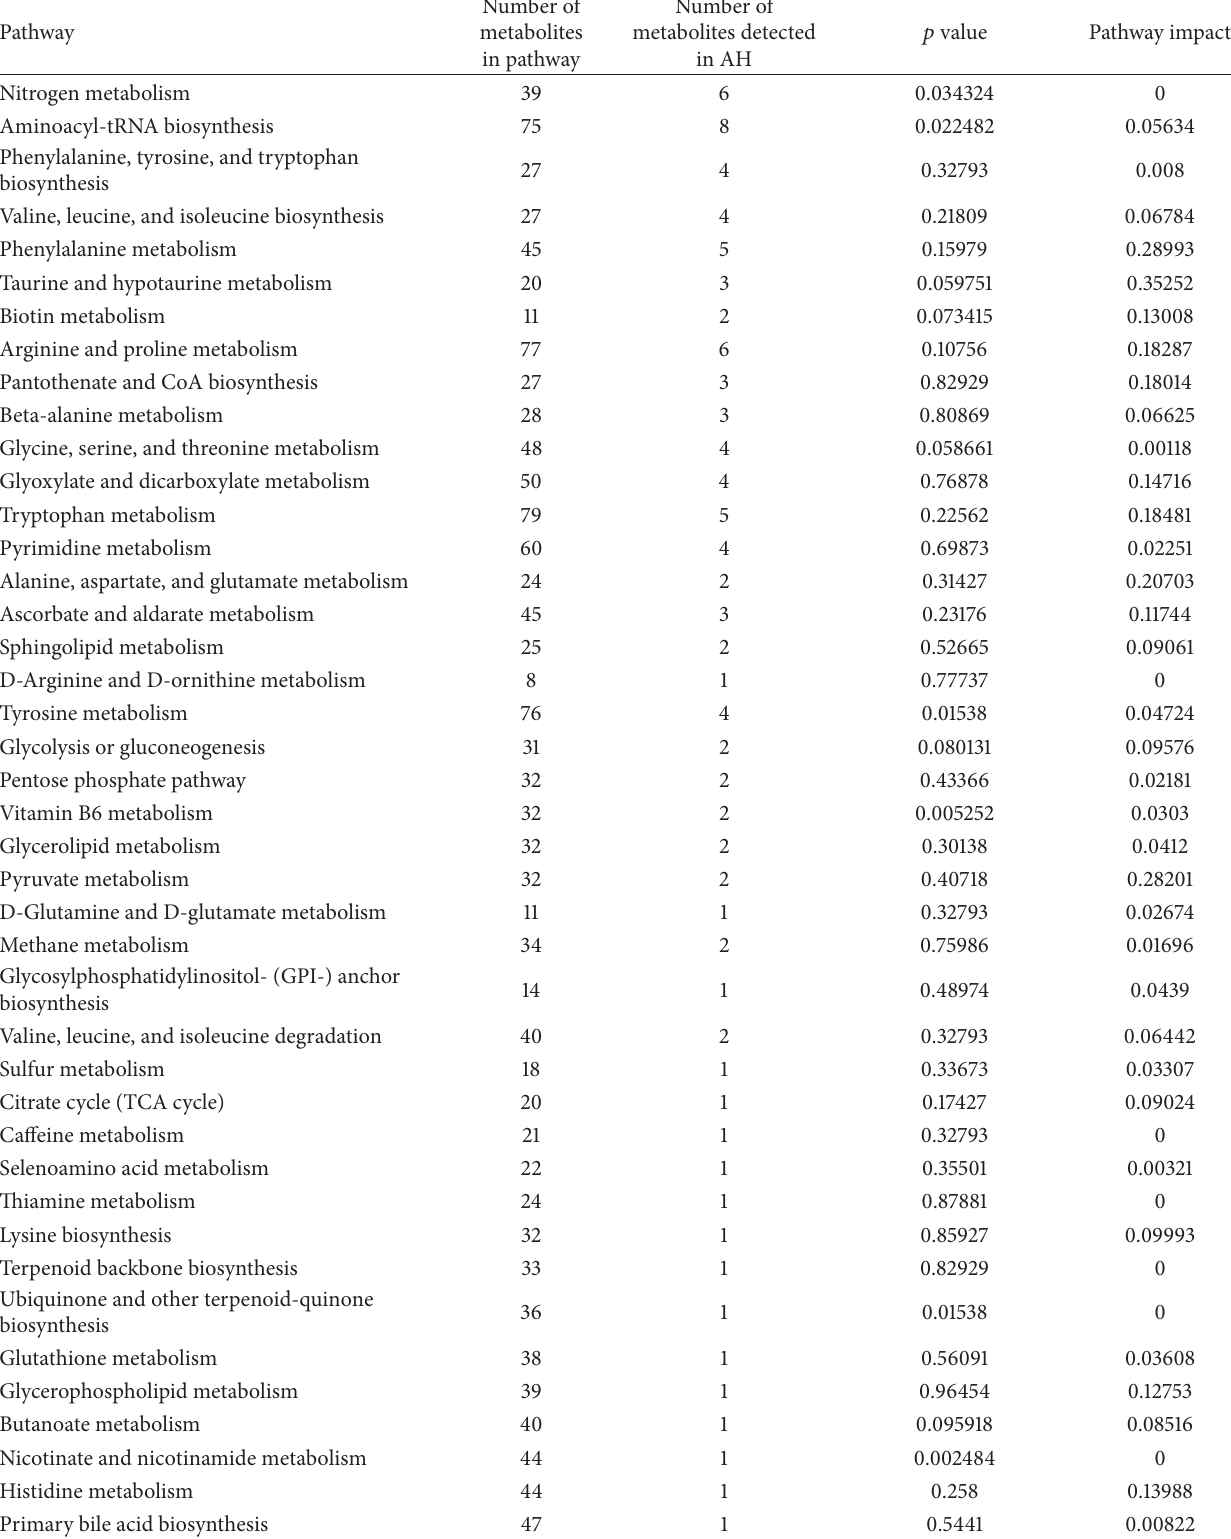
Table 3: The list of metabolic pathways to which putatively identified metabolites belong in aqueous humor.